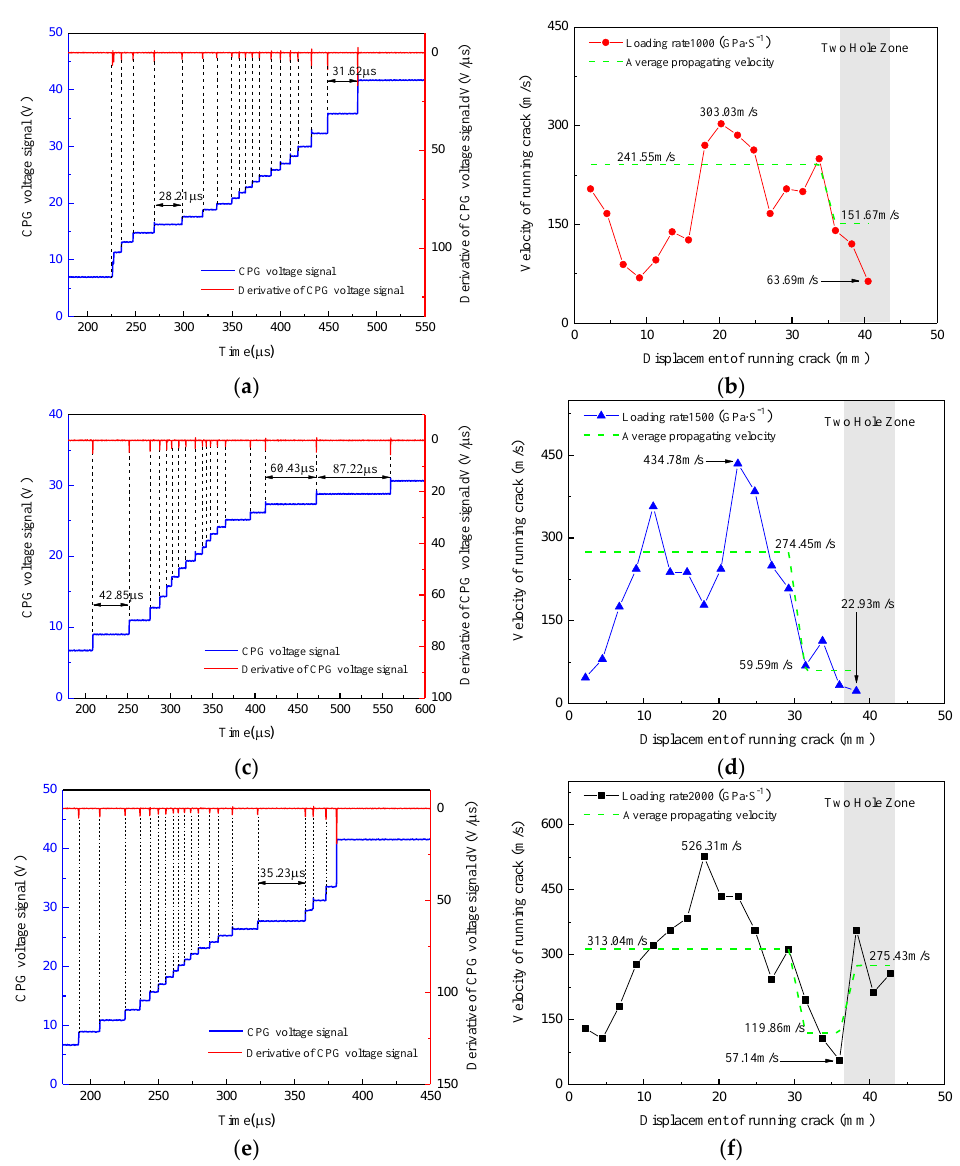
Figure 6. Voltage signal and derivative, with respect to time recorded from the crack propagation gauge (CPG) and crack propagation velocity. (a) The CPG voltage signal of HT-1 specimen. (b) The crack propagation velocity curves of HT-1 specimen. (c) The CPG voltage signal of HT-2 specimen. (d) The crack propagation velocity curves of HT-2 specimen. (e) The CPG voltage signal of HT-3 specimen. (f) The crack propagation velocity curves of HT-3 specimen.